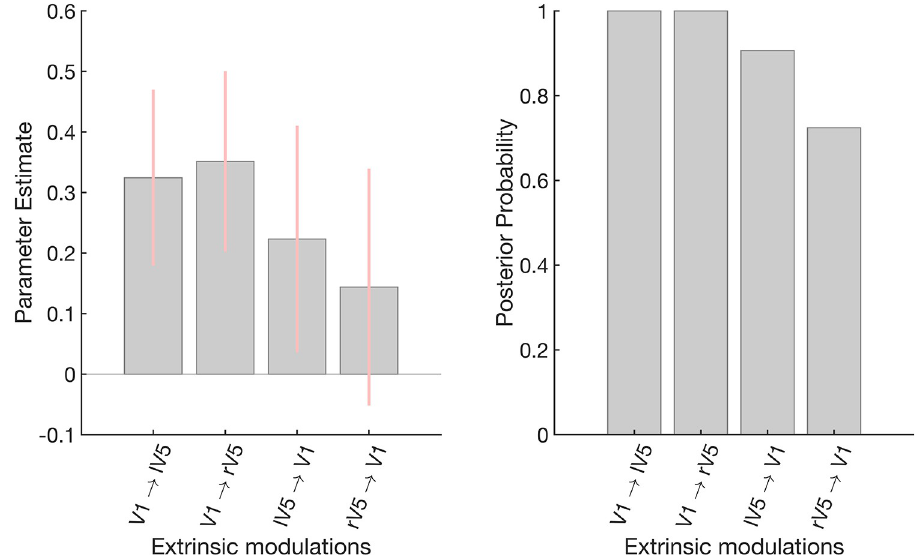
Fig 4. Extrinsic connectivity modulations. This figure shows the group-level results of the extrinsic connectivity modulations associated with EC states (relative to EO). More specifically, the mean posterior and 90% Bayesian confidence intervals (pink) after the greedy search algorithm and Bayesian model averaging are shown. Note that the estimated parameters are log-scale parameters (i.e., the parameters in the right column of Table 1 ( θ used different x-axis labelling for clarity.). The right panel shows the posterior probabilities of the extrinsic connections. increase during EC. The backwards connections appear to increase as well, however, the evidence is not conclusive (Pp < 0.95). The posterior probabilities (Pp) are 100%, 100%, 90% and 72% for V1 ! lV5, V1 ! rV5, lV5 ! V1 and rV5 ! V1,